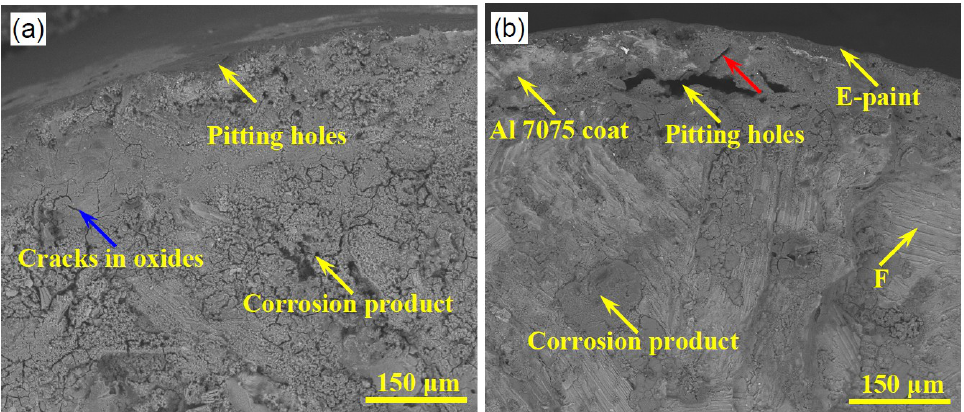
Figure 10. SEM images show the pitting holes leading to delamination on the fatigue fracture surfaces of the specimens tested at a stress amplitude of 90 MPa ( a ) EP and ( b ) CS + EP.